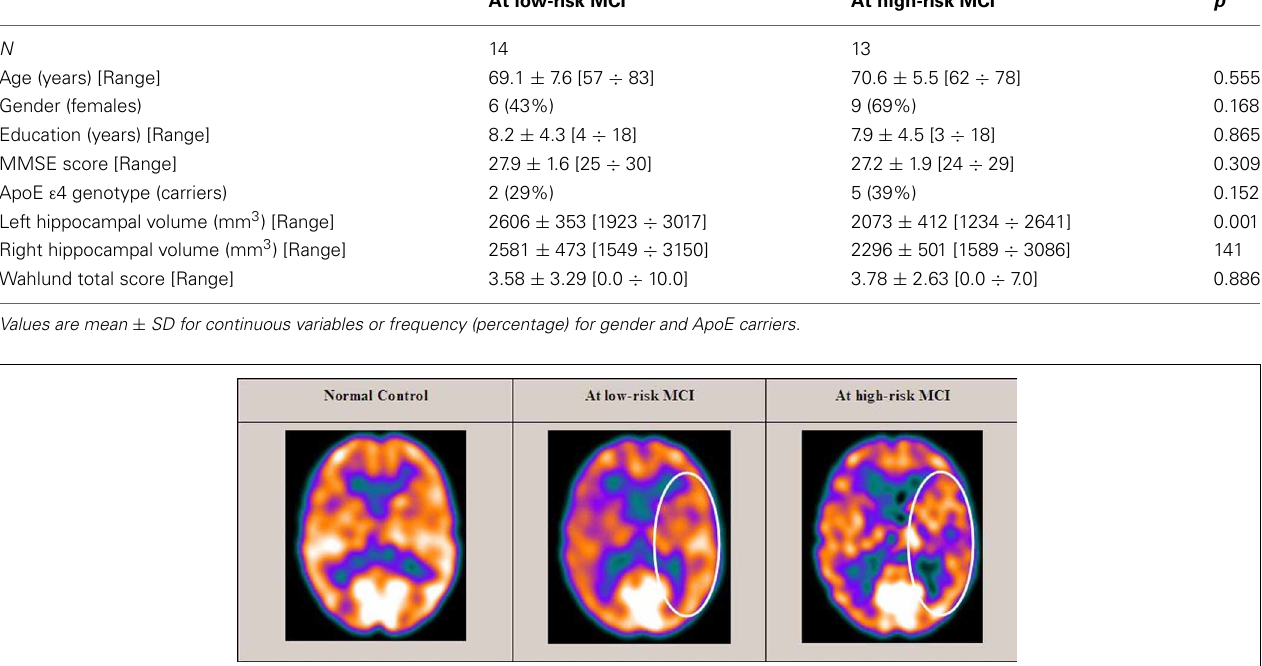
Table 1 | Socio-demographic, clinical, and volumetric features in MCI patients by risk to develop AD. At low-risk MCI At high-risk MCI p